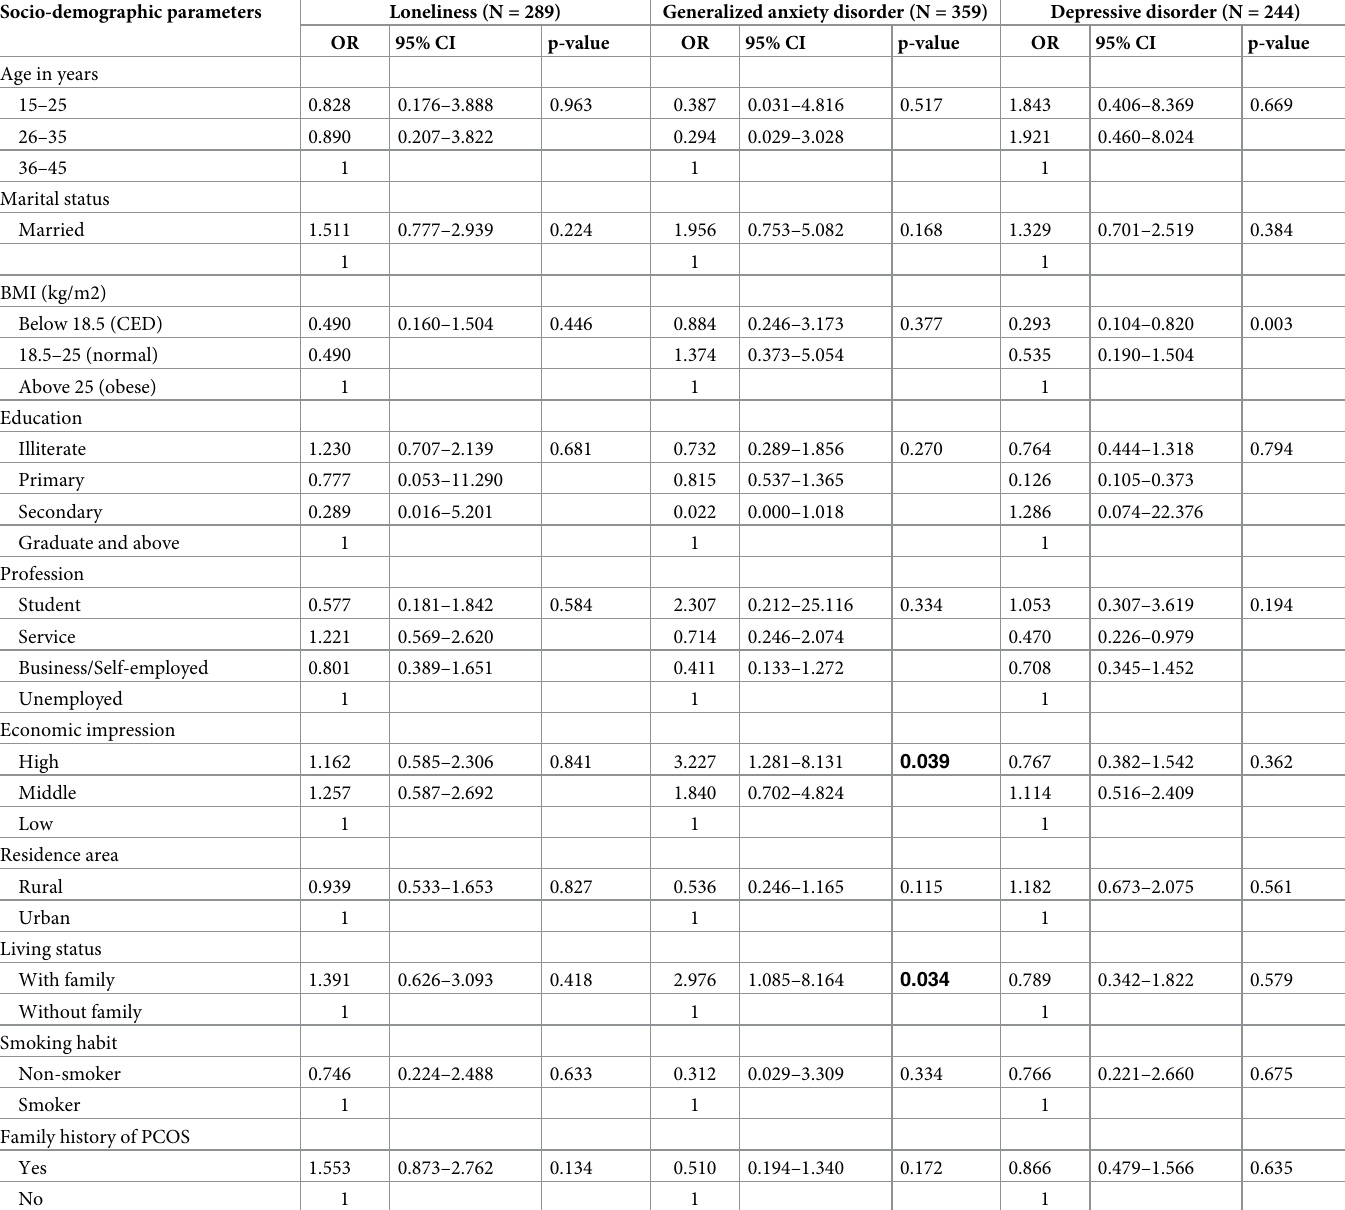
Table 3. Regression analysis of socio-demographic variables and their association with mental health problems among the patients suffering from polycystic ovar- ian syndrome. Socio-demographic